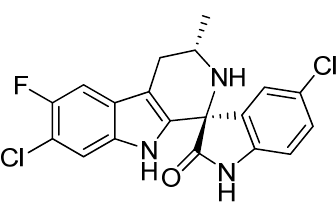
Figure 1. Structure of